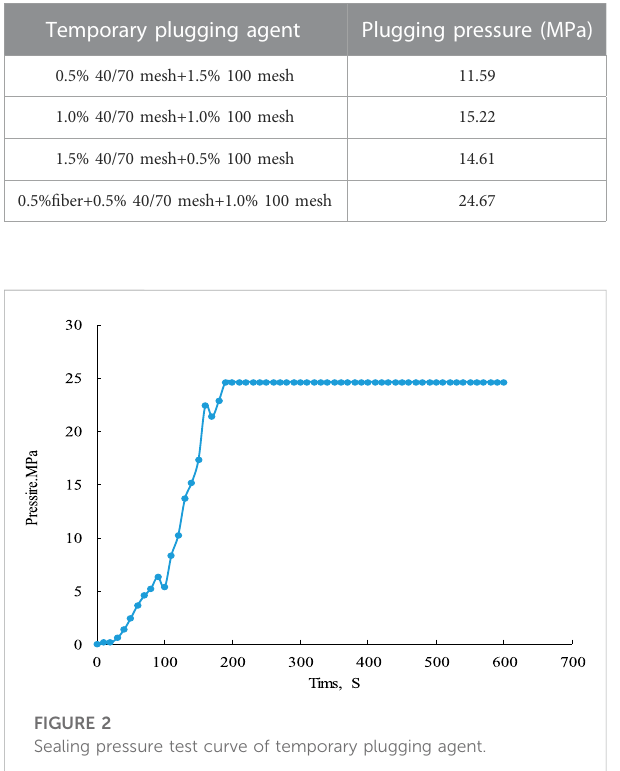
TABLE 2 Test results of plugging pressure with different temporary plugging agents.